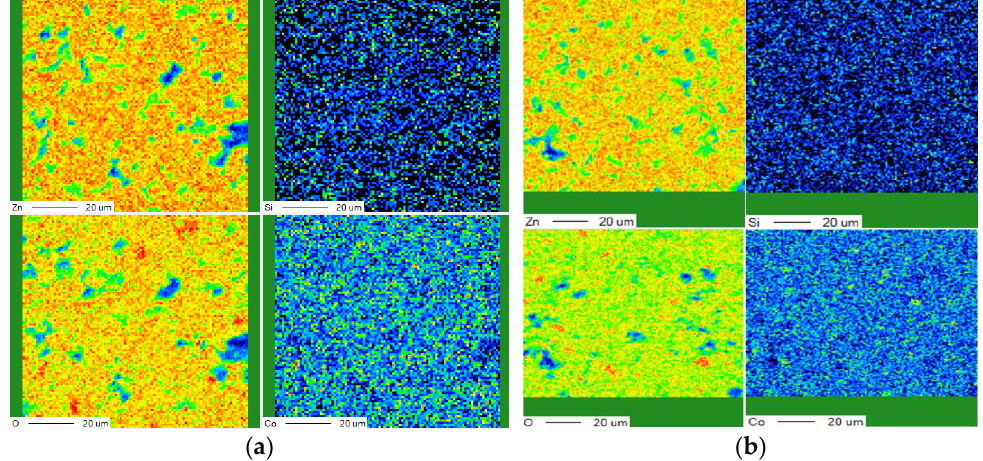
Figure 8. Elemental configuration map of D71 valve plate. ( a ) Elemental configuration map of ordinary-gradient valve plate; ( b ) Elemental configuration map of high-gradient valve plate.